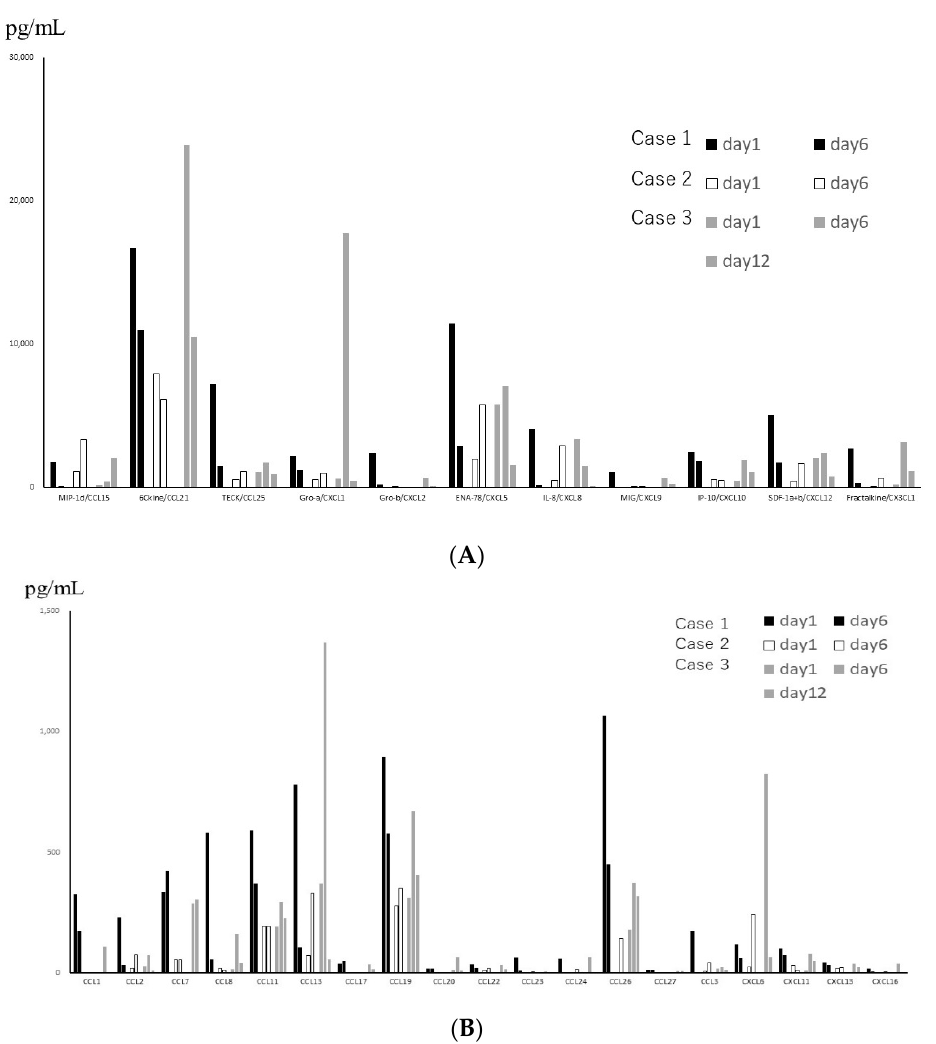
Figure 2. ( A ) Levels of chemokines with high expression in Tracheal aspirate fluid (TAF) obtained from 3 patients with severe disease, on different days. Black, white and gray bars represent the data of 3 different patients. ( B ) Levels of chemokines with low expression in TAF obtained from 3 patients with severe disease, on different days.